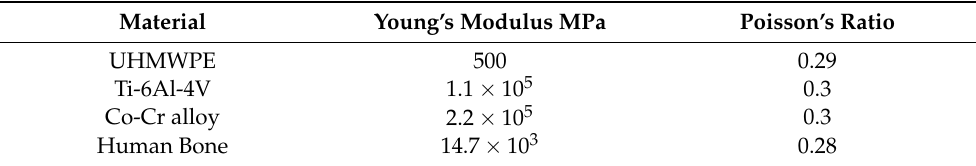
Table 1. Materials properties used in finite element analysis [6].